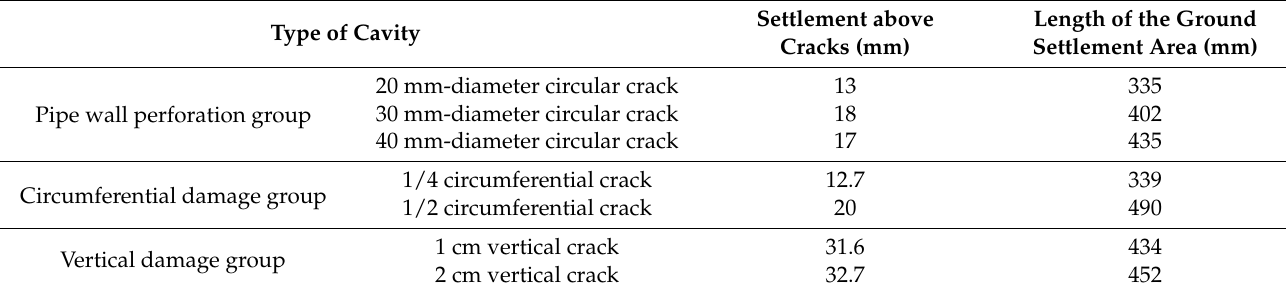
Table 2. Settlement and length of ground